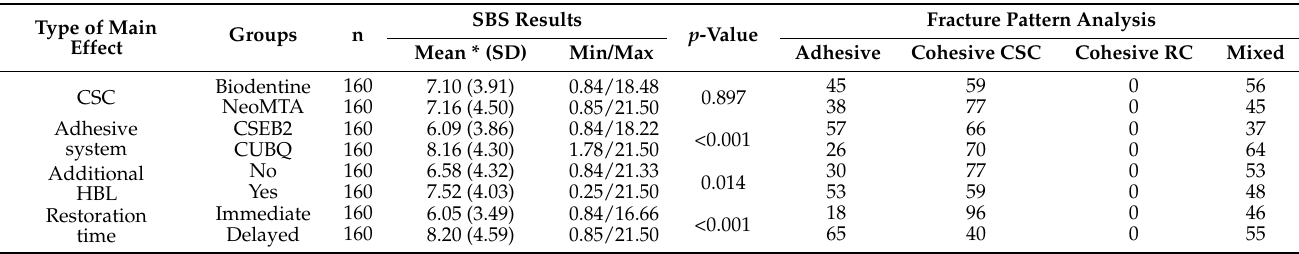
Table 2. Results of the tested groups regarding mean shear bond strength values and fracture patterns concerning main effects comparisons.